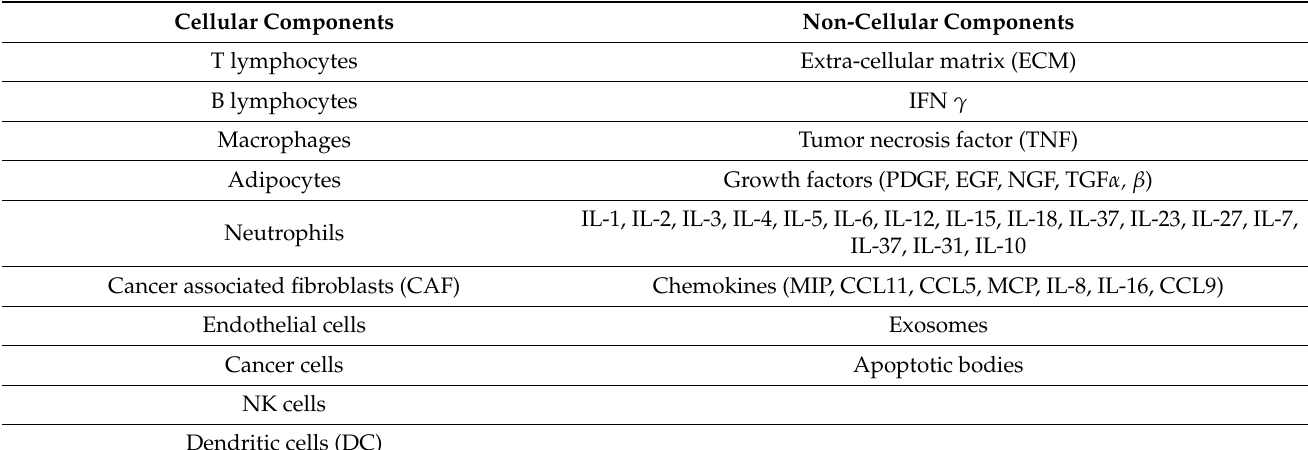
Table 1. The essential cellular and non-cellular components of the tumor microenvironment [6–8]. Cellular